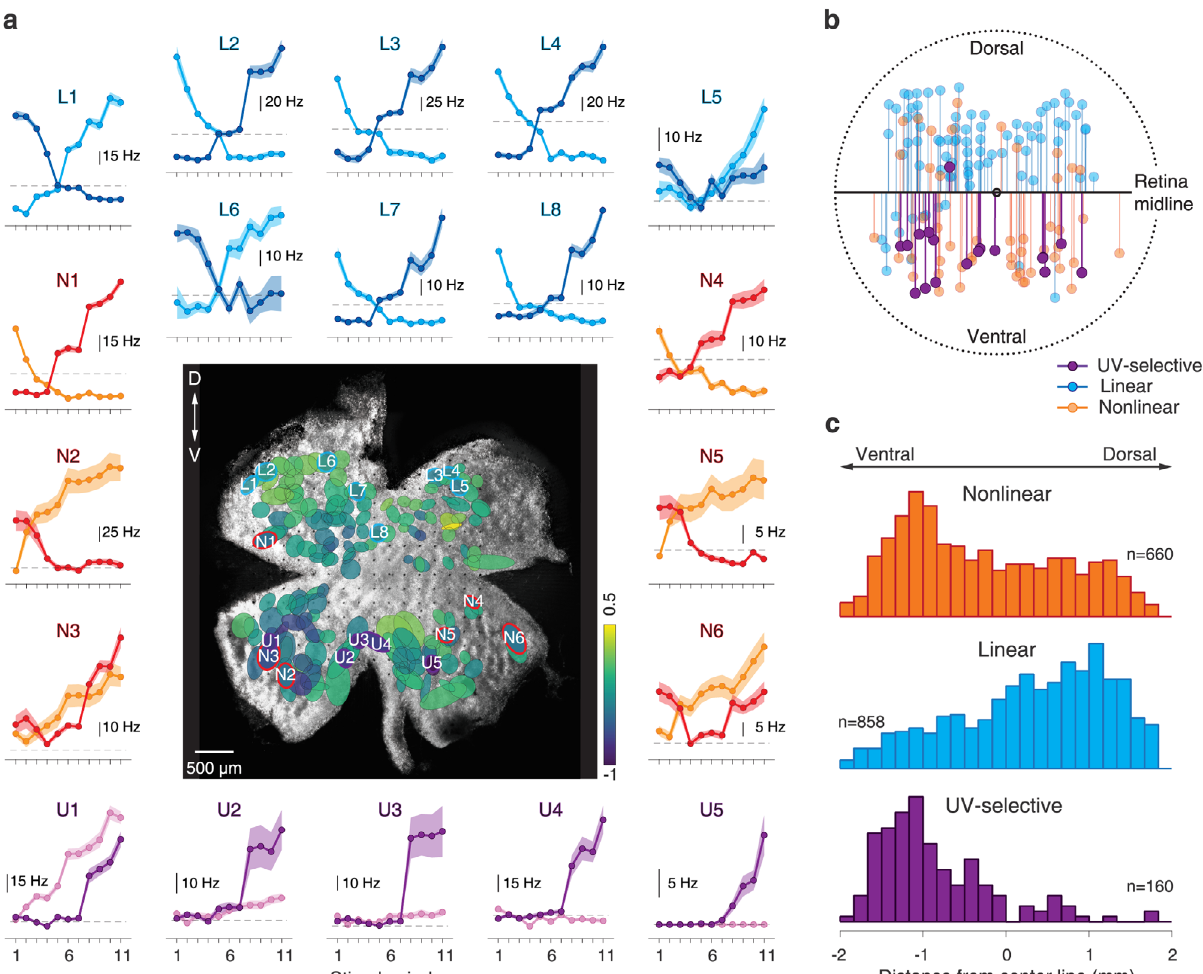
Fig. 8 Locations and potential functions of chromatically nonlinear cells. a Image of a sample retina with ganglion cell receptive fi elds (ellipses corresponding to the 1.5- σ contour of a fi tted Gaussian with color indicating the UV-green index) and chromatic-integration curves for some of the cells. The labels identify the cells as linear (L … ), nonlinear (N … ), or UV-selective (U … ) and mark the position of the receptive fi eld on the retina. Shaded regions around the curves show mean ± SEM. b Distances of receptive fi eld centers to the midline for the retina shown in a . c Distribution of receptive fi eld distances from the midline for chromatically nonlinear, linear, and UV-selective cells over all analyzed retinas. Note that the prevalence of UV-selective cells in the ventral retina is by methodological design, as these cells were used to identify the ventral side, and the corresponding distribution is shown here only for